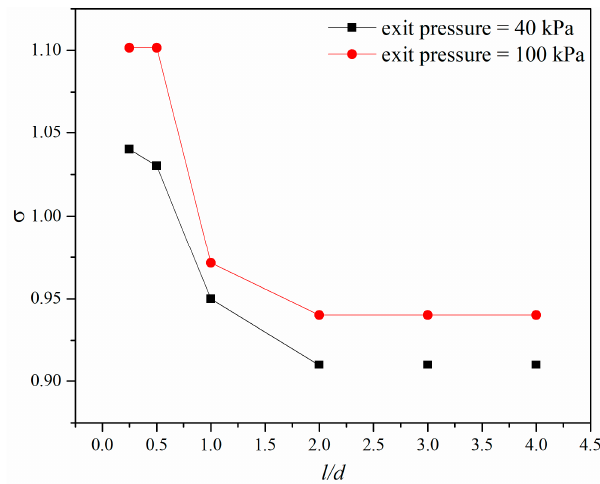
Figure 9. Cavitation number under different exit pressures for the same pressure ratio.